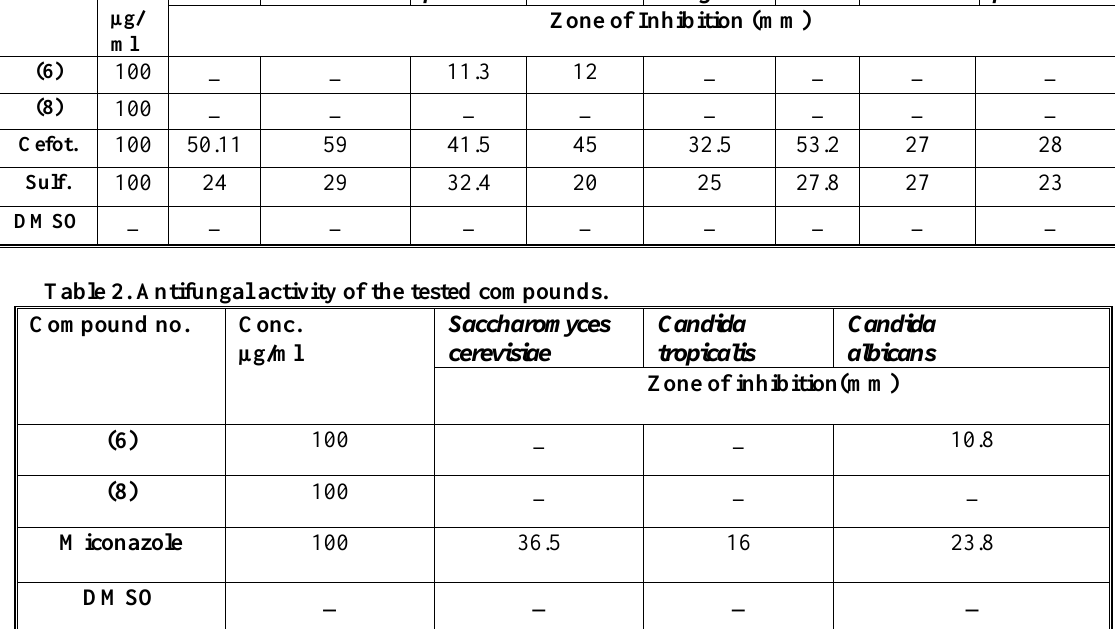
Table 1. Antibacterial activity of the tested compounds. Cpd.